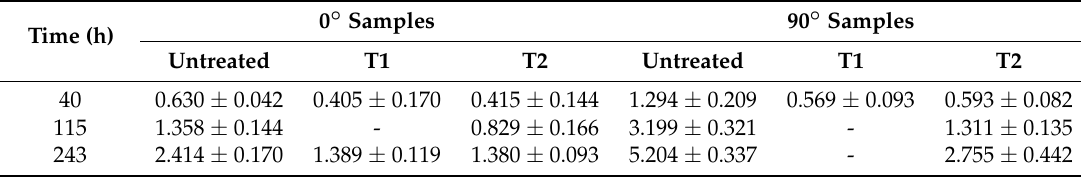
Table 4. Weight increase (%) of FA treated and untreated composites after water absorption (average and standard deviation).